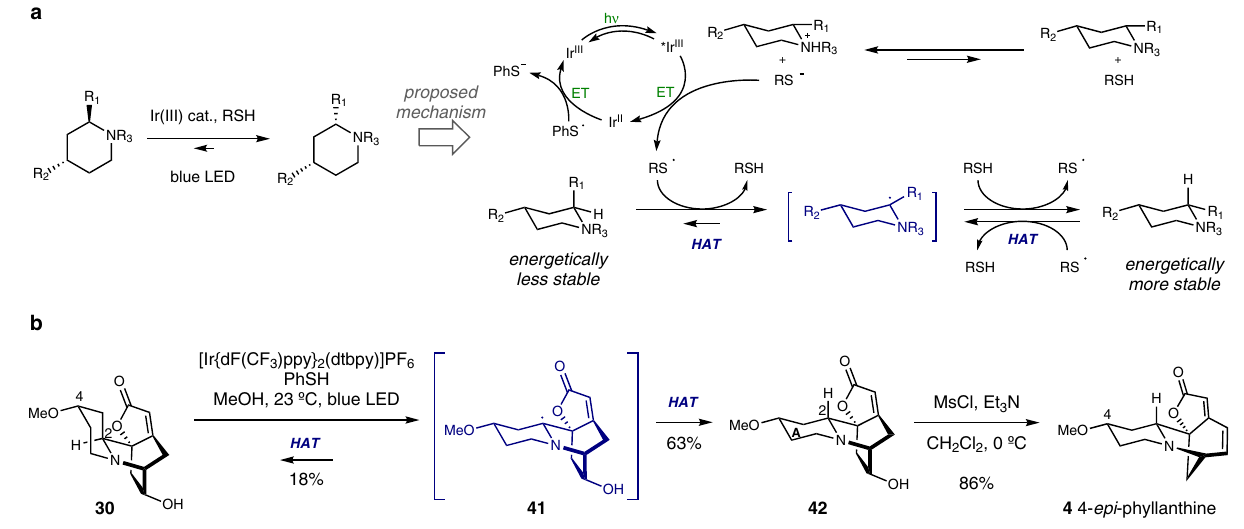
30 enables the synthesis of 4- epi -phyllanthine ( 4 ). ET electron transfer, HAT hydrogen atom transfer.